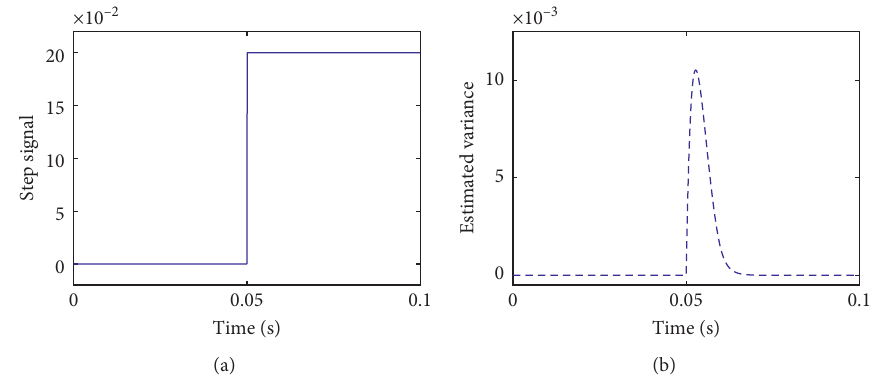
Figure 6: Variance estimation output of the step signal.